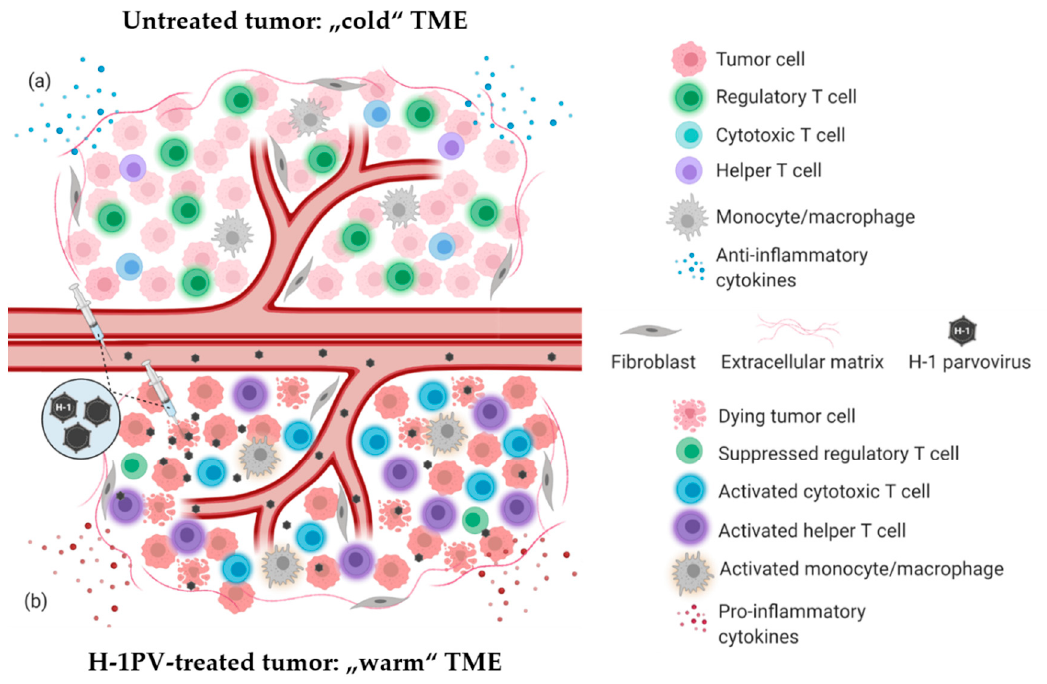
Figure 1. H-1PV-induced modulation of tumor microenvironment immune landscape. ( a ) Immunosuppressive (“cold”) tumor microenvironment (TME) of a solid tumor. The tumor is often infiltrated with abundant immunosuppressive reg- ulatory T cells (Treg)/myeloid-derived suppressor cells (MDSC). Tumor-infiltrating lymphocytes (TILs) (CD8+ CTLs, CD4+ Th cells) are scarce and/or anergic. Tumor and various TME cells produce anti-inflammatory cytokines to maintain immune suppression and facilitate tumor growth and dissemination. ( b ) Tumor infection with H-1PV results in immunogenic tumor cell death leading to the release proinflammatory cytokines, pathogen- and danger-associated molecular patterns (PAMPs and DAMPs), which alarm the immune system. The infection of tumor cells does not necessarily have to be productive for this immuno-stimulating effect to be achieved. Furthermore, abortive infection of immunocytes (CTLs, Th cells, monocytes/macrophages) with H-1PV can also lead to their activation. In contrast, H-1PV inhibits the immune suppressive functions of Treg cells. An immunological switch takes place and converts the “cold” TME into a “warmed up” (inflamed) one. Virus-mediated immuno-conversion of TME favors the mounting of enhanced antitumor immune re- sponses.